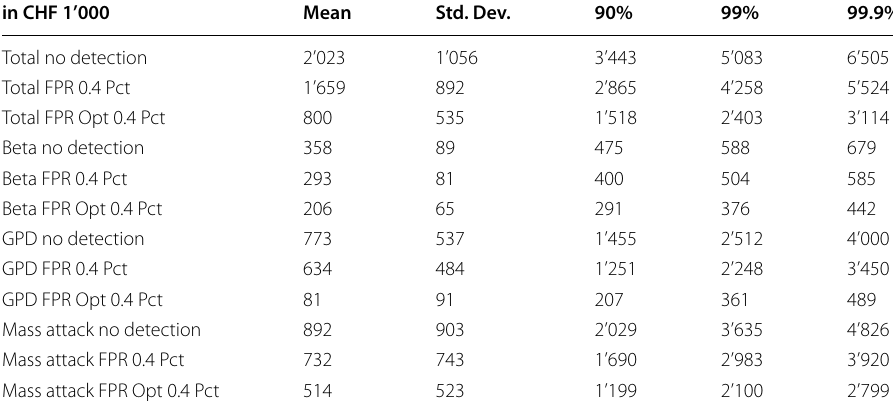
Table 6 Simulated moments and quantiles for online banking based on 100’000 Monte Carlo